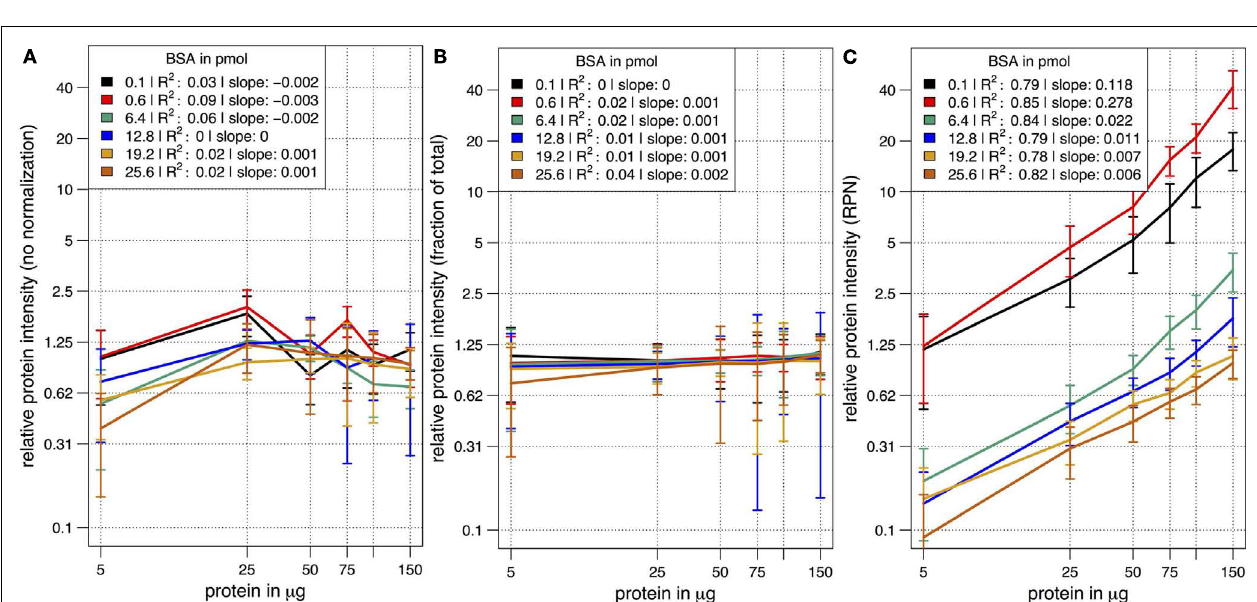
intensity sum per sample did not display differences in total protein amount at the different protein loadings. Instead, the average abundance fraction is constant throughout. (C) With RPN a linear relationship of protein intensities with increased amounts of protein became apparent at all combinations of total protein and spiked